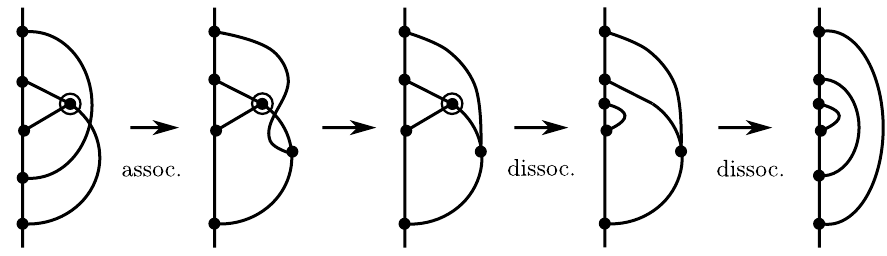
Figure 8 . Reduction of an amplitude involving a bulk interaction (ringed vertex) using associators and dissociators. In the second step we exchange two discrete irreps at a bulk interaction which gives a minus